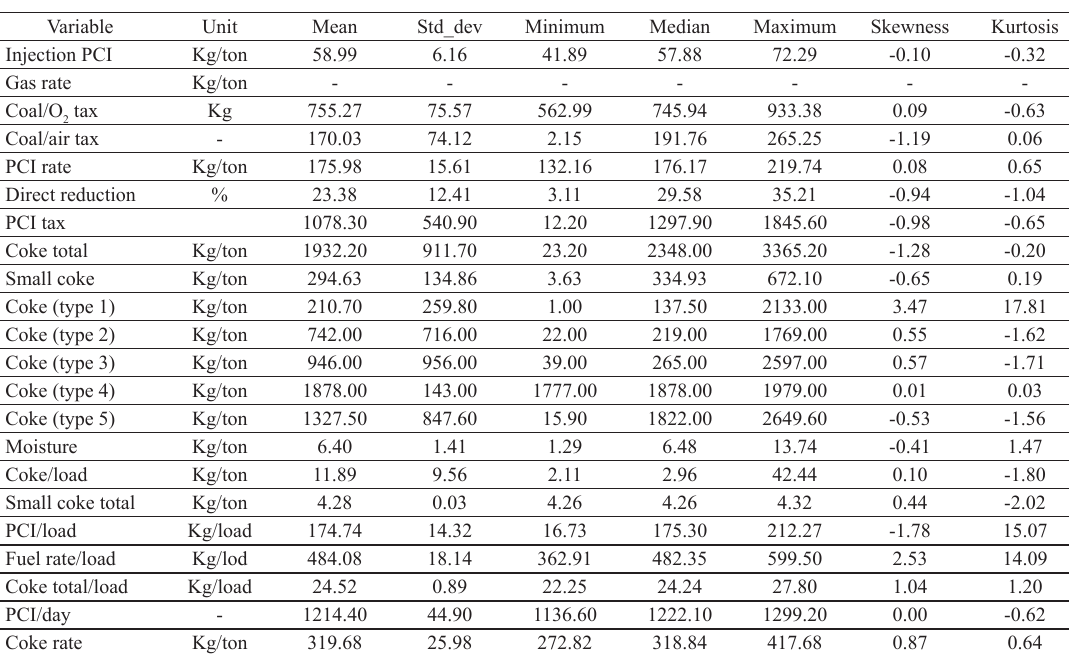
Table 10. Fuel variables.